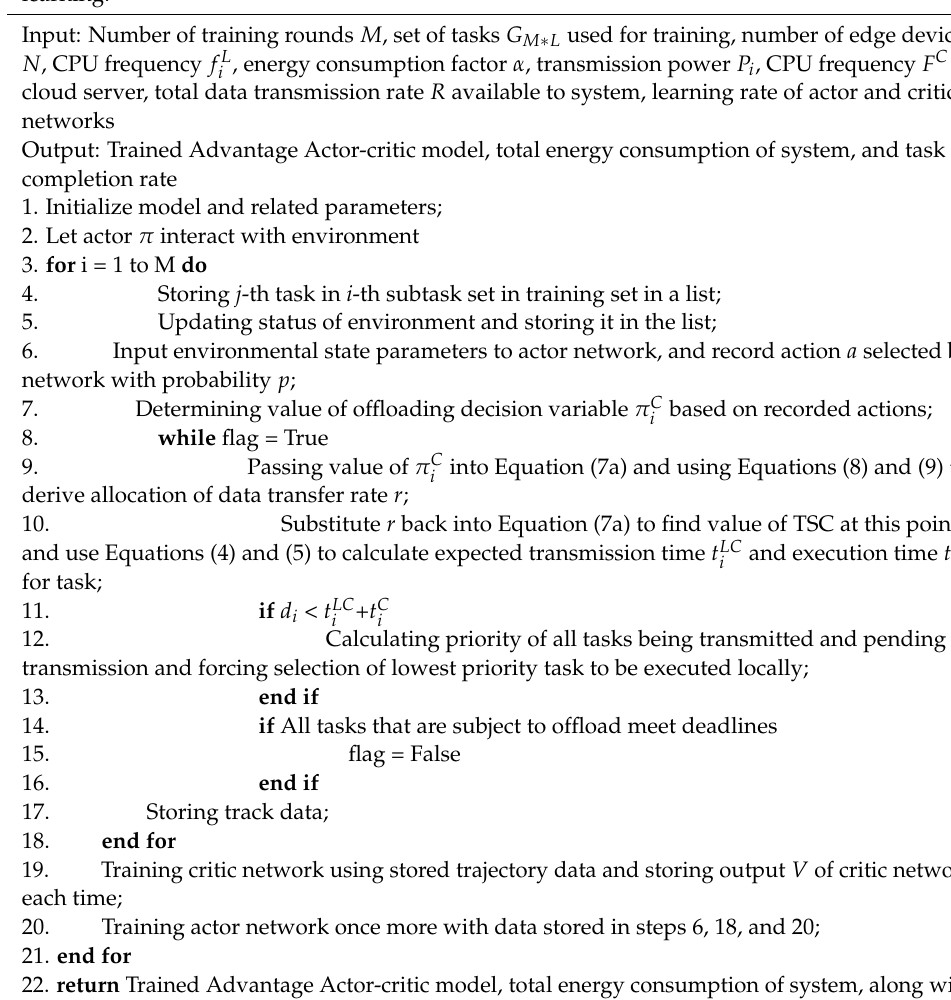
Algorithm 1: Offloading algorithm for edge computing tasks based on deep reinforcement